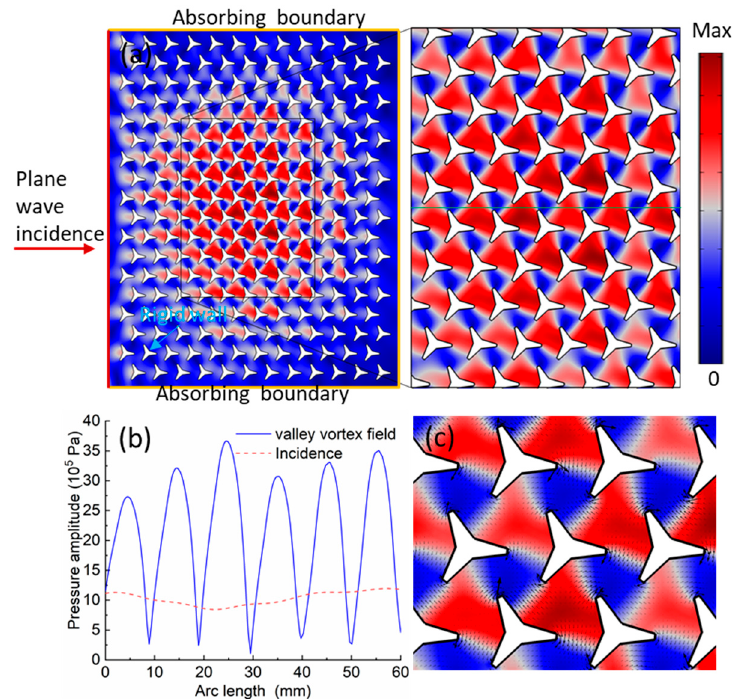
Figure 2. The acoustic field distribution and acoustic radiation force calculation. ( a ) The simulation model and the calculated acoustic pressure fields and its enlarged view when the plane wave was incident from left to right. ( b ) The extracted amplitude of the incidence (the red dash line) and the excited valley vortex field (the blue line) from the green line in ( a ). ( c ) The calculated acoustic radiation force potential and